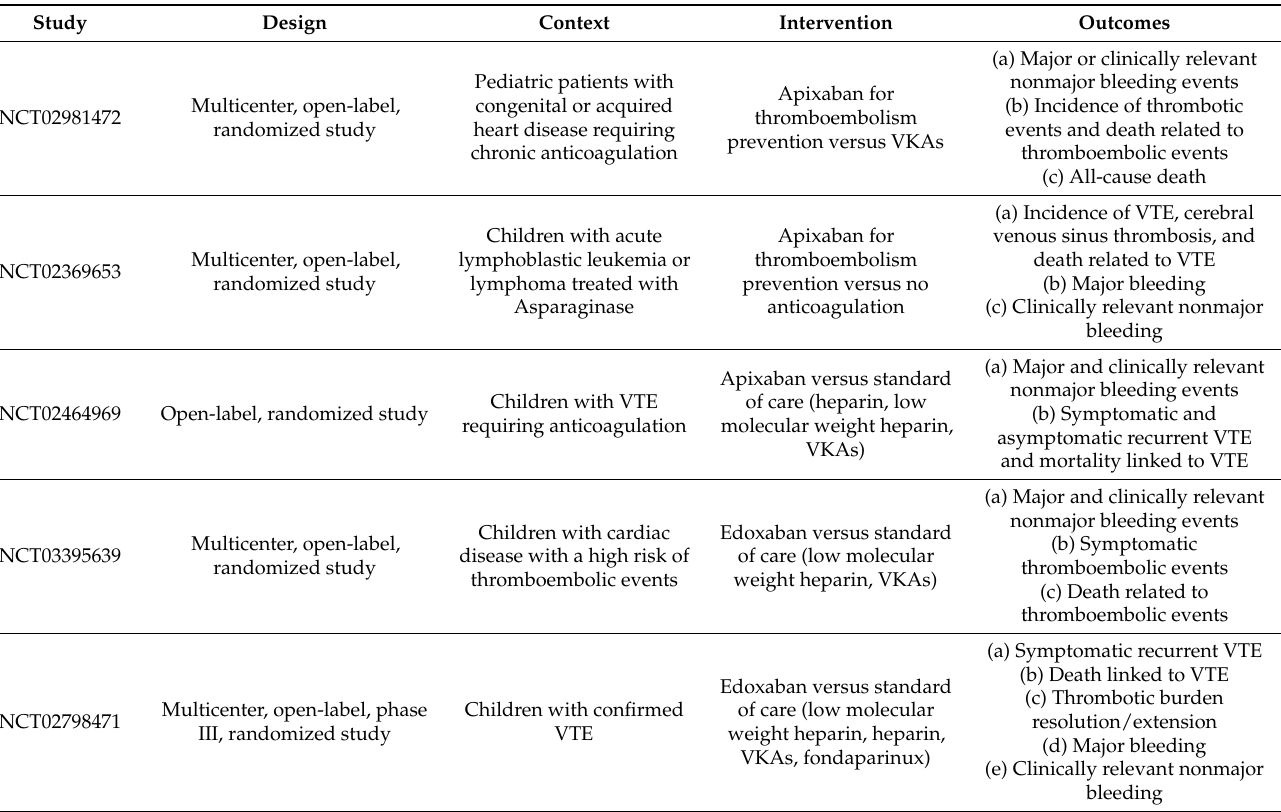
Table 2. Ongoing clinical trials investigating antithrombotic therapy with DOAC in